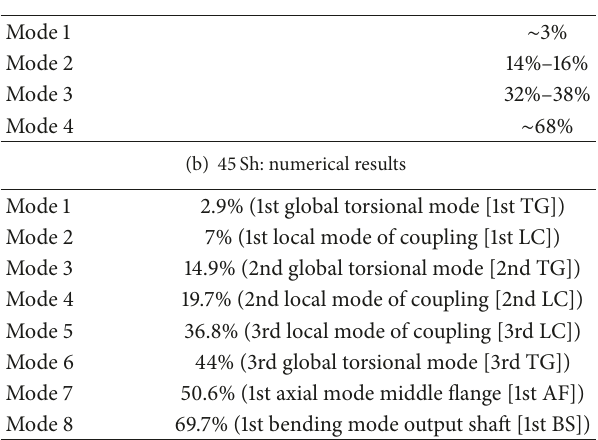
Table 5: 45 Sh configuration. (a) List of experimental resonances. (b) List of numerical (FE) natural frequencies, in percentage of 𝑓 max .